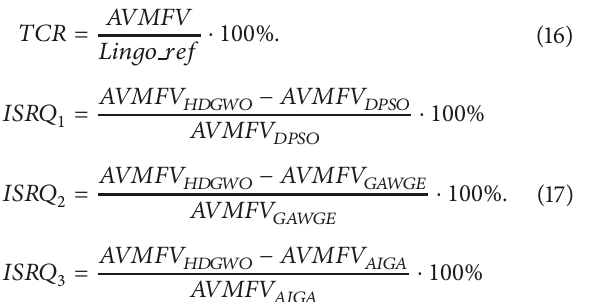
Figure 7: The number of successful trials of the HDGWO, the DPSO, the GAWGE, and the